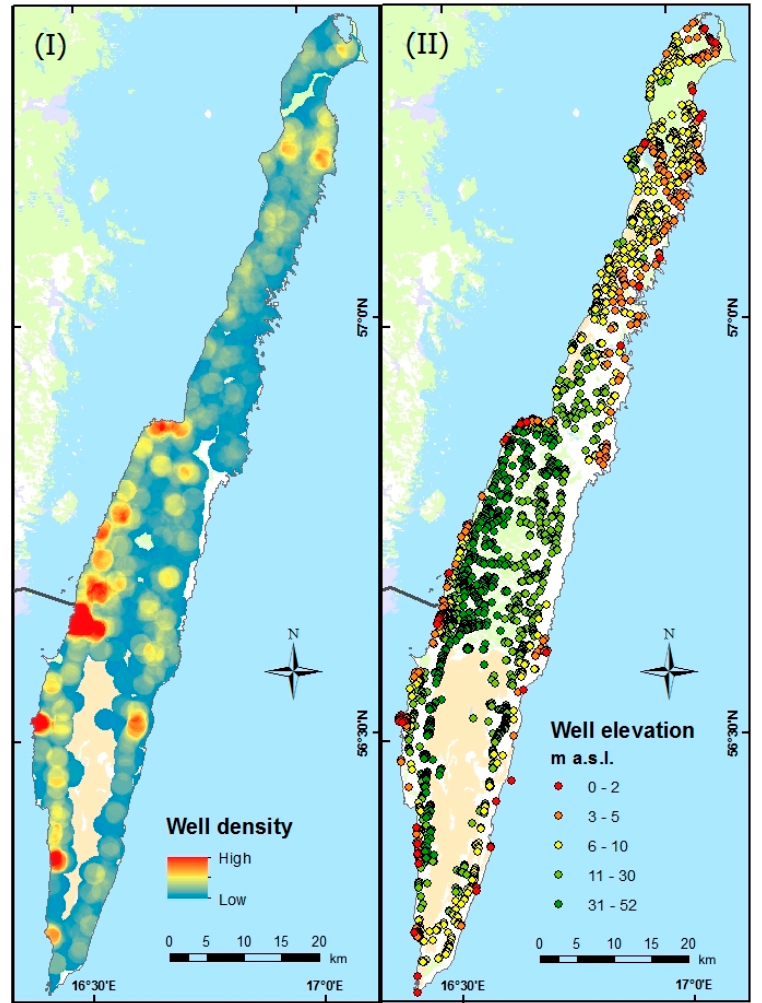
Figure 2. ( I ) Density of wells shown as point density; ( II ) elevation of all 3438 wells; 99 wells (3% of total) are located at or below 2 m.a.s.l. These will be directly inundated in a 2 m sea level rise scenario .